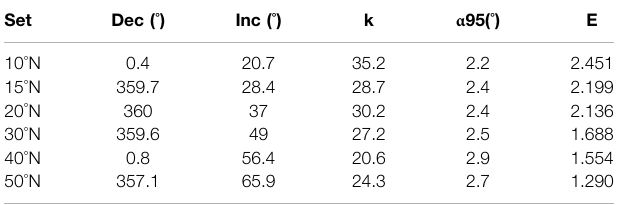
TABLE 1 | List of the simulated paleomagnetic direction sets. TABLE 2 | List of the strain simulation matrices applied to the circular distribution